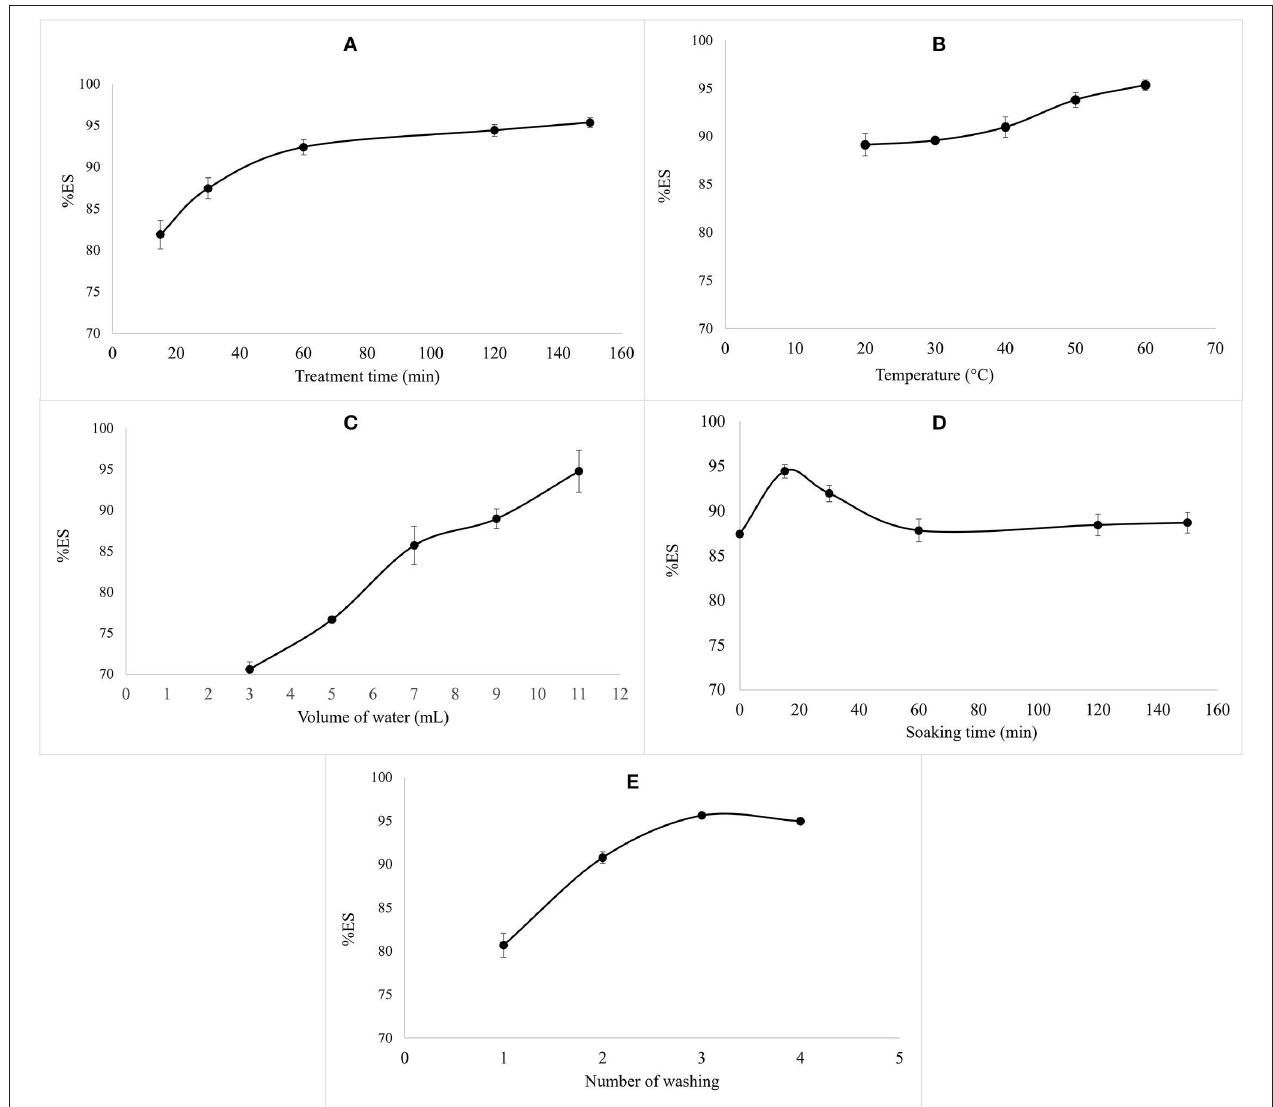
FIGURE 1 | The effect of variation of treatment time (A) , water temperature (B) , volume of water (C) , soaking time (D) , and number of washing times (E) on